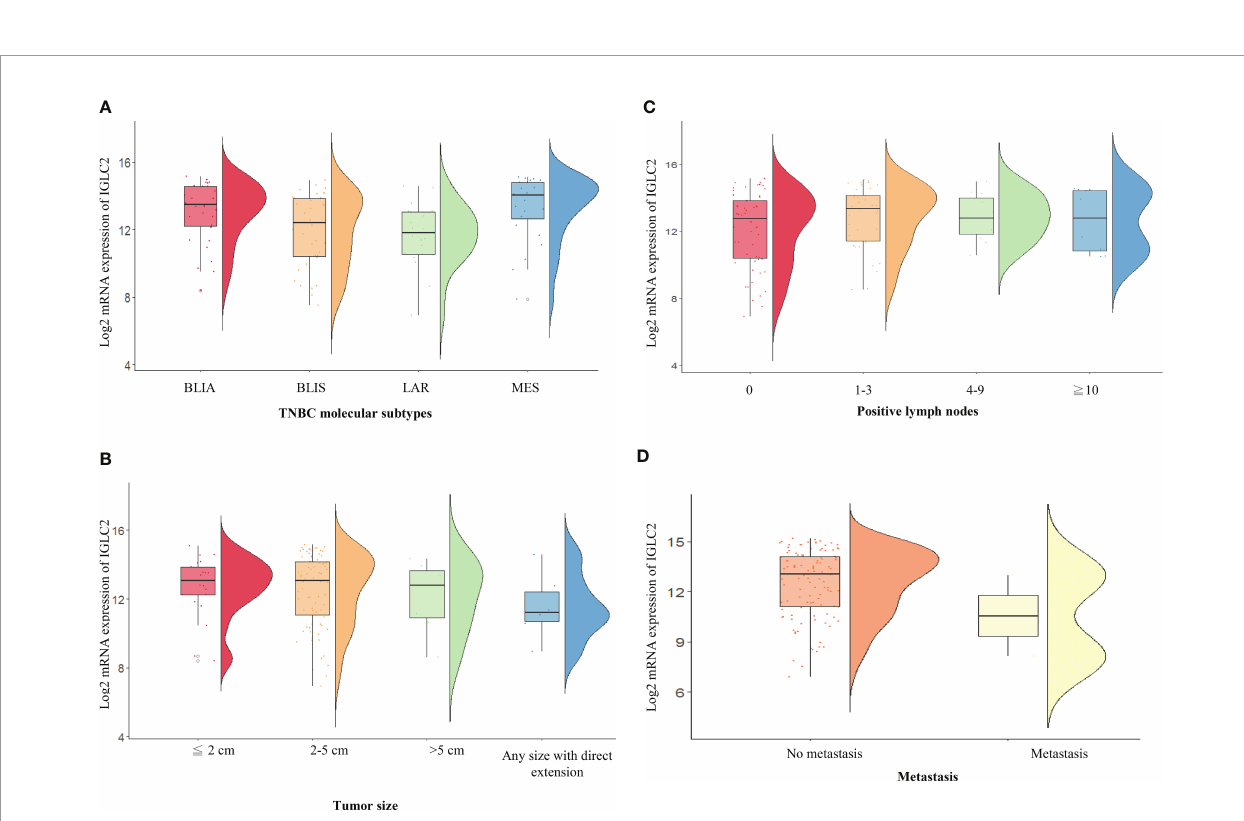
FIGURE 3 | RainCloud plots of IGLC2 mRNA expression grouped by (A) TNBC molecular subtypes [BLIA, BLIS, LAR, and MES], (B) tumor size ( ≤ 2, 2 – 5, and >5 cm), (C) the number of positive lymph nodes (0, 1 – 3, 4 – 9, and ≥ 10), and (D) metastasis (no and yes) using the GSE76275 data